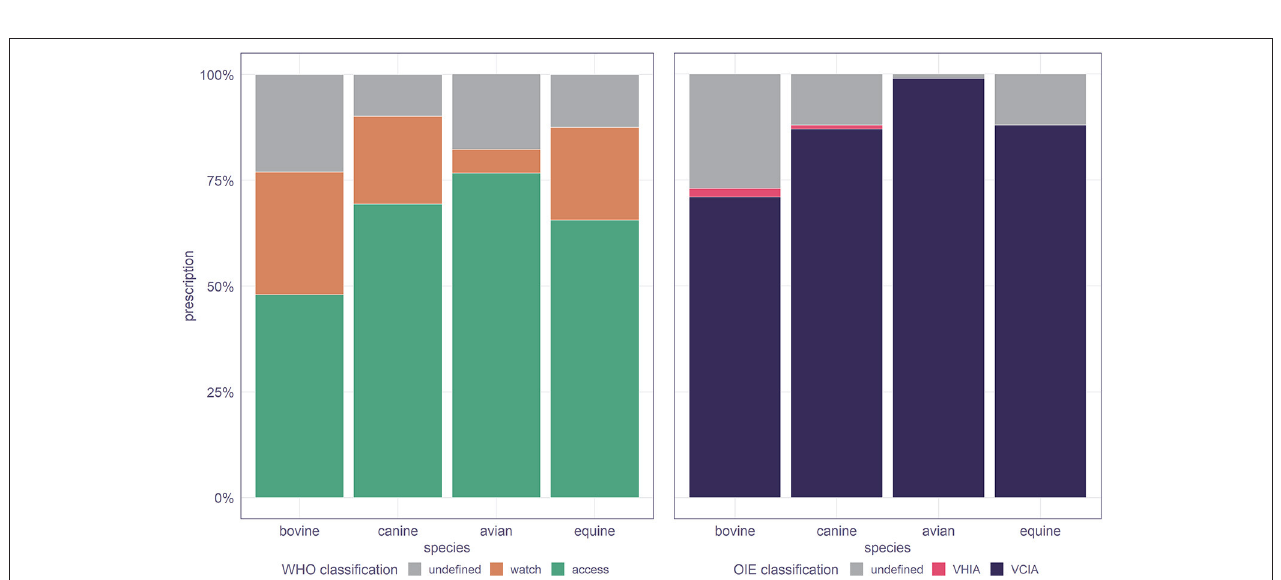
FIGURE 5 | Antibiotics prescribed to different species in veterinary consultation records of the WRLDj of Bhutan in 2017, stratified according to the AWaRe index and OIE classification. VCIA, veterinary critically important antimicrobial agents; VHIA, veterinary highly important antimicrobial